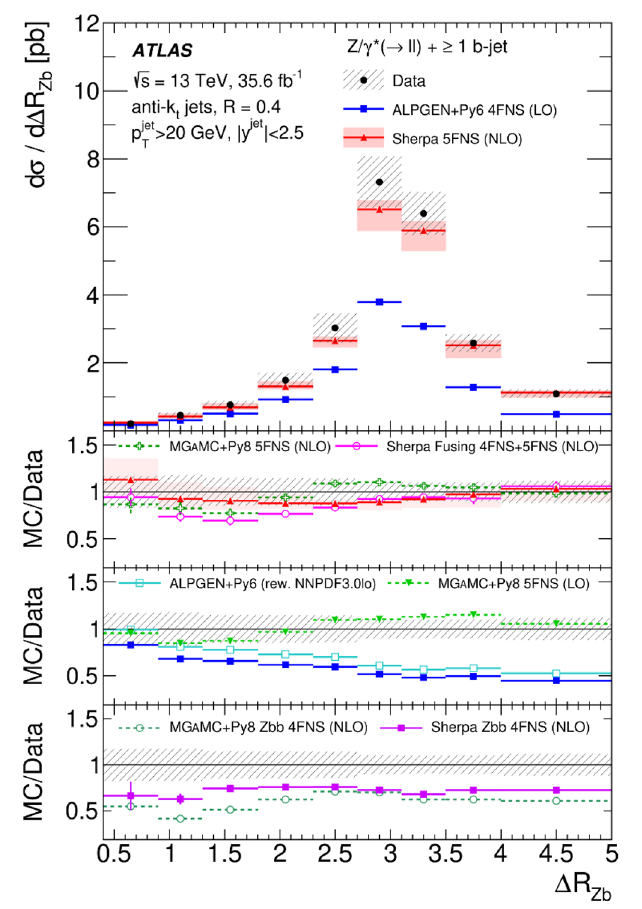
Figure 11 . Measured cross-section as a function of the (cid:1) R between the Z -boson candidate and the leading b -jet in events with at least one b -jet. The data are compared with the predictions from Sherpa 5FNS (NLO) , Alpgen + Py6 4 FNS (LO) , Sherpa Fusing 4FNS+5FNS (NLO) , Sherpa Zbb 4FNS (NLO) , MGaMC + Py8 5FNS (LO) , MGaMC + Py8 Zbb 4FNS (NLO) and MGaMC + Py8 5FNS (NLO) . The error bars correspond to the statistical uncertainty, and the hatched bands to the statistical and systematic uncertainties of the data, added in quadrature. The red band corresponds to the statistical and theoretical uncertainties of Sherpa 5FNS (NLO) added in quadrature. Only statistical uncertainties are shown for the other